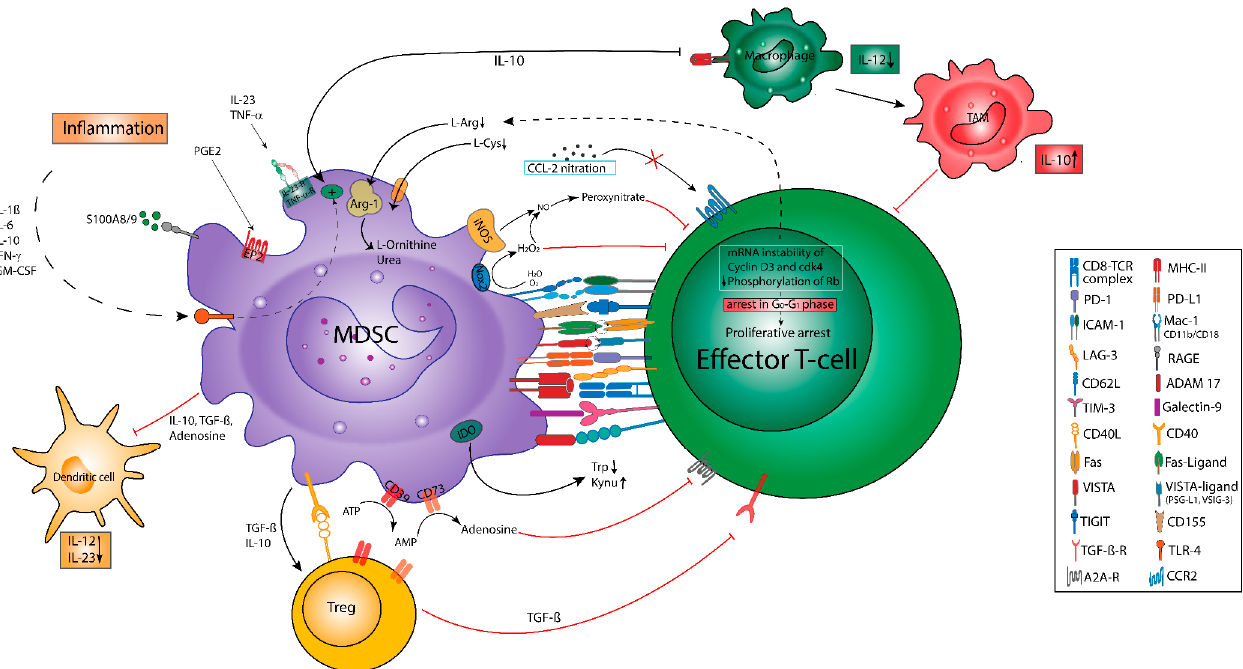
Figure 2. MDSC-mediated inhibition of T cell activation and proliferation. Direct inhibition of Teff involves cell–cell contacts (e.g., via checkpoint molecules), which induce proliferative arrest apoptosis, a reduced migratory activity, and attenuated T cell recirculation. T cell activation is further inhibited via soluble mediators and metabolic pathways: MDSC contribute to L-arginine and L-cysteine depletion in the TME, which causes proliferative arrest via mRNA instability of cyclin-dependent kinase 4 (cdk4), reduced phosphorylation of retinoblastoma protein (Rb), and the loss of the T cell receptor (TCR) ζ -chain on Teff. G-MDSC express high levels of NADPH oxidase (Nox)-2, mediating ROS-dependent inhibition of Teff. The cooperative activities of Nox-2, Arginase (Arg)-1, and inducible nitric oxide synthase (iNOS) generate peroxynitrite, which drives protein nitration resulting in desensitization of the TCR and the interference with IL-2 receptor signaling. The consumption of L-tryptophan and the accumulation of kynurenines in the TME add up to the inhibition of Teff and regulatory T cells (Treg) induction. CD39 and CD73 degrade extracellular ATP to adenosine, which enhances T cell inhibition and Treg induction. Indirect mechanisms of MDSC-mediated immunosuppression include the induction and expansion of Treg both via cell–cell contact-dependent mechanisms and soluble mediators (e.g., TGF- β , IL-10, prostaglandine-E2; PGE2; and A2A-receptor mediated signaling). Likewise, MDSC imprint a tolerogenic function in DC via IL-10, TGF- β , and adenosine. Both the accumulation of Treg and TAM add up to Teff inhibition within the TME. Macrophages are skewed toward an M2 phenotype via IL-10, thus impairing IL-12 production. Tumor-derived soluble factors contribute to STAT3-mediated upregulation of proteins including Nox-2, cell survival proteins (Cyclin D1), or S100A8/9, promoting MDSC accumulation (via S100A8/9 ligation to RAGE), survival, and